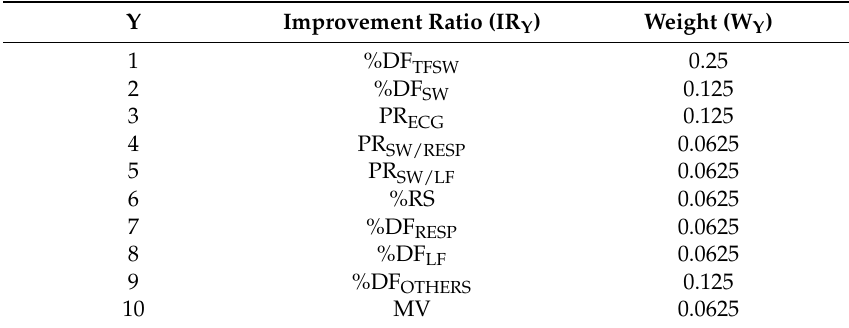
Table 2. Weights for the improvement ratios of parameters involved in the selection of the most appropriate combination of